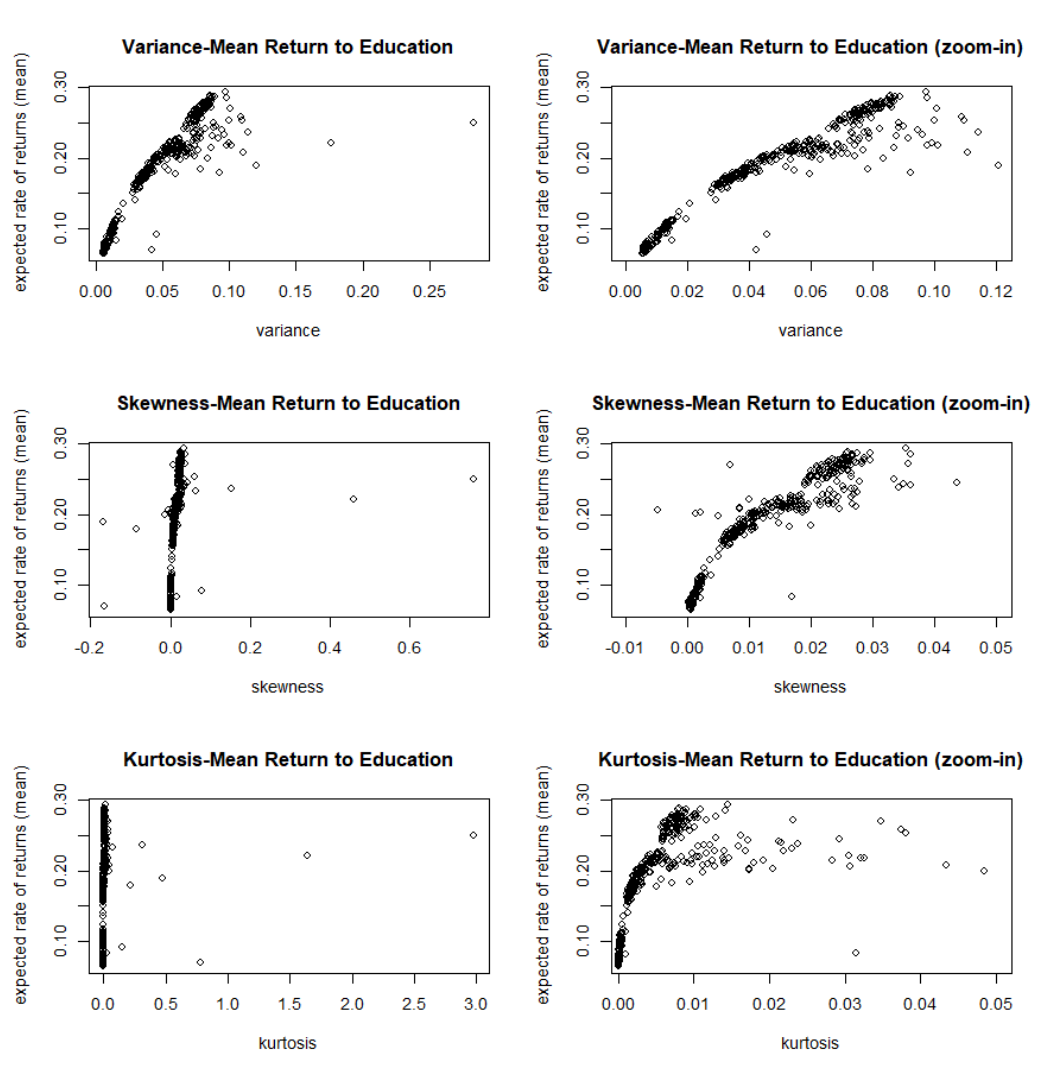
Figure 8. Higher moments against the expected returns